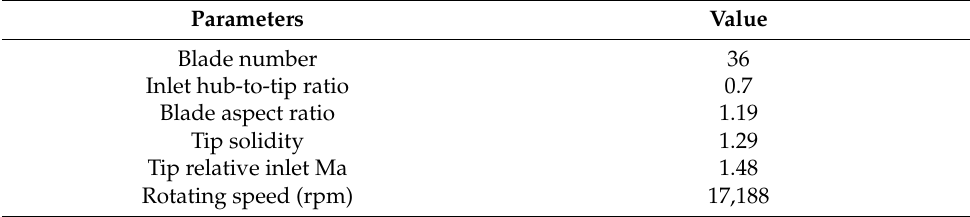
Figure 4. Schematic of the NASA Rotor 37. Table 1. Design parameters of the NASA Rotor 37.